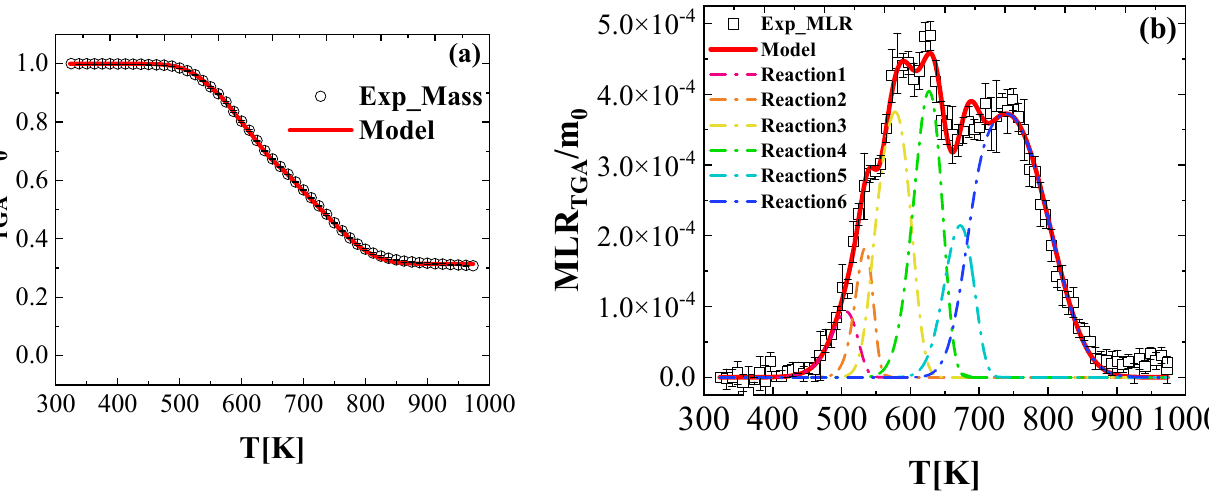
Figure 3. Experimental and simulated ( a ) normalized total mass and ( b ) normalized mass loss rate as a function of temperature, obtained at a heating rate of 10 K min − 1 in nitrogen.